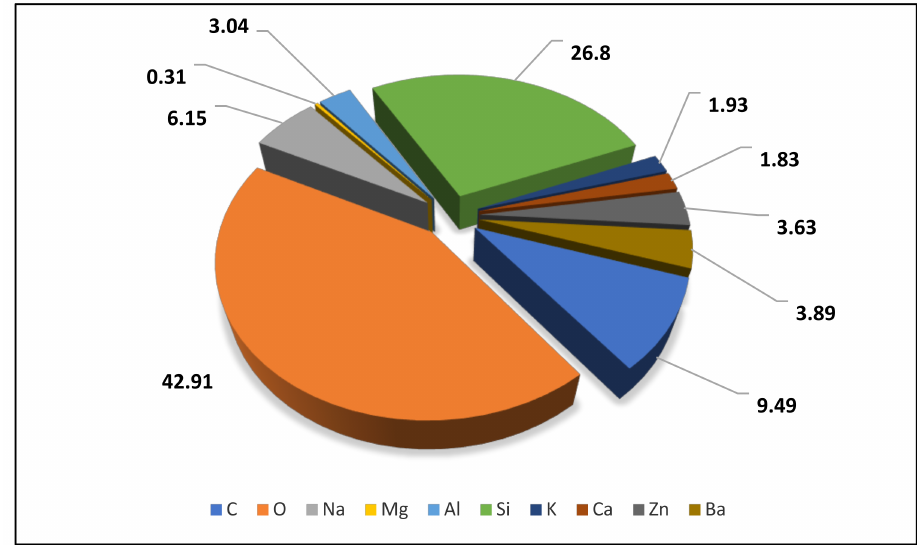
Figure 8. Weight percentage of each element found in glass-fiber filter paper from EDX analysis for blank